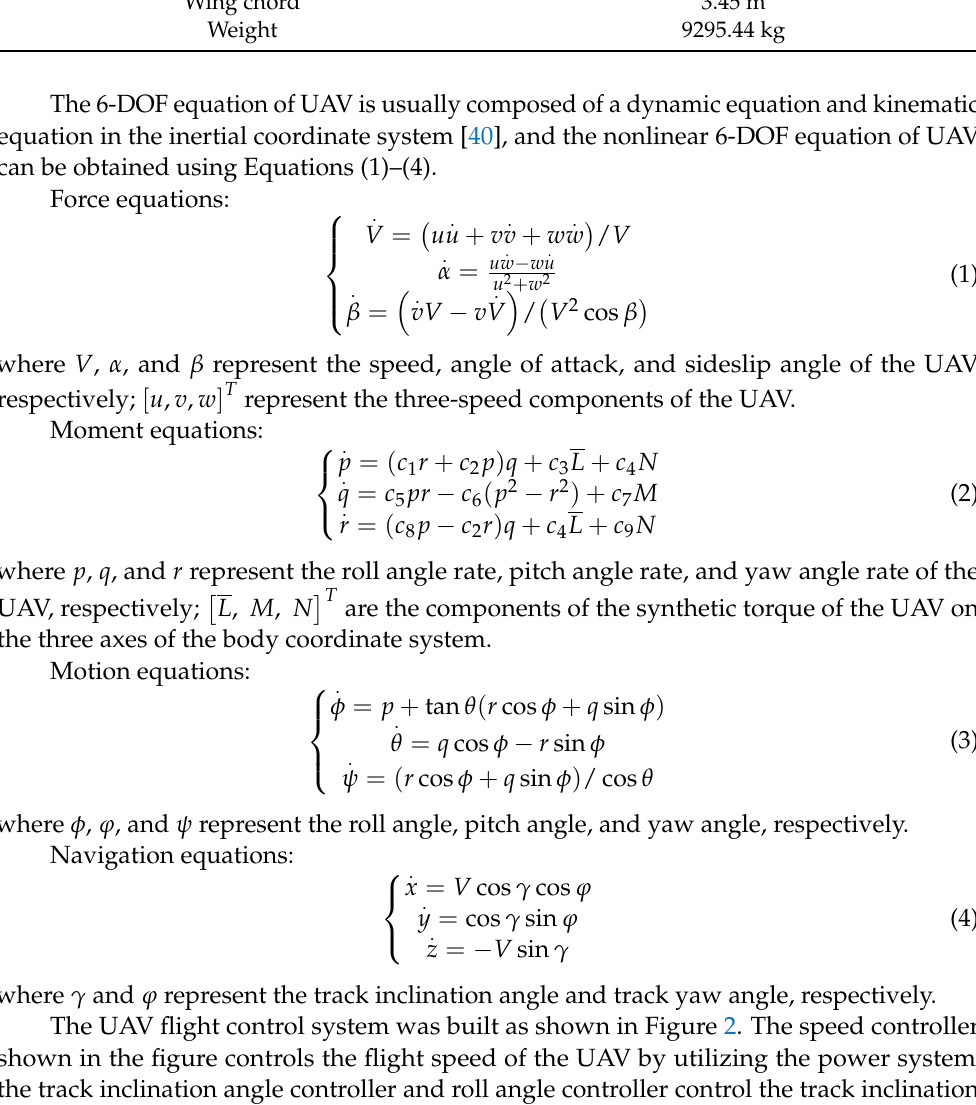
Table 1. Aircraft performance parameters of the F16 aircraft. Rudder Surface Value Range Wing